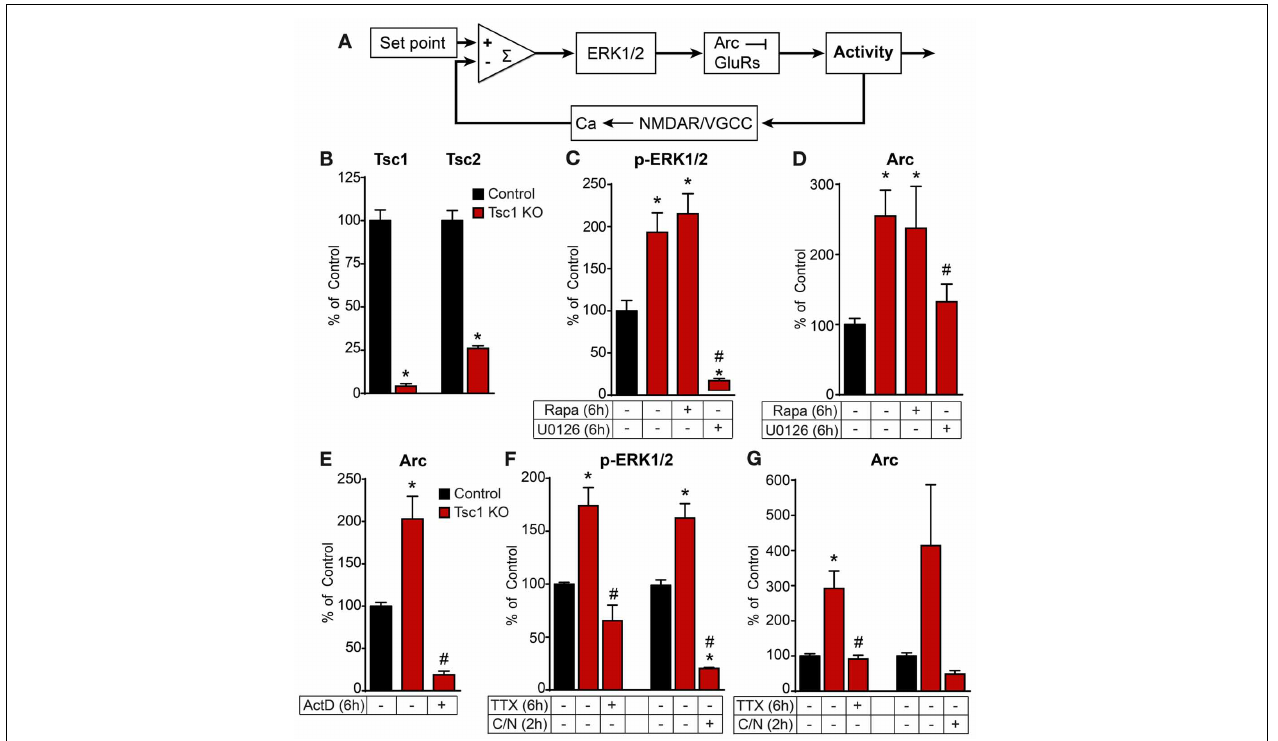
FIGURE 4 | The ERK1/2-Arc negative feedback pathway is tonically active in Tsc1 KO neurons and is independent of mTOR. (A) Schematic depicting the ERK1/2-Arc negative feedback pathway regulating hippocampal network activity. (B) Bar graphs show western blot data of Tsc1 and Tsc2 protein levels normalized to GAPDH or β -Actin loading control on DIV 14 from control (black) and Tsc1 KO (red) cultures. (C,D) Western blot data of p-ERK1/2 normalized to total ERK1/2 (C) and Arc protein normalized to β -Actin loading control (D) in control and Tsc1 KO cultures following six hour